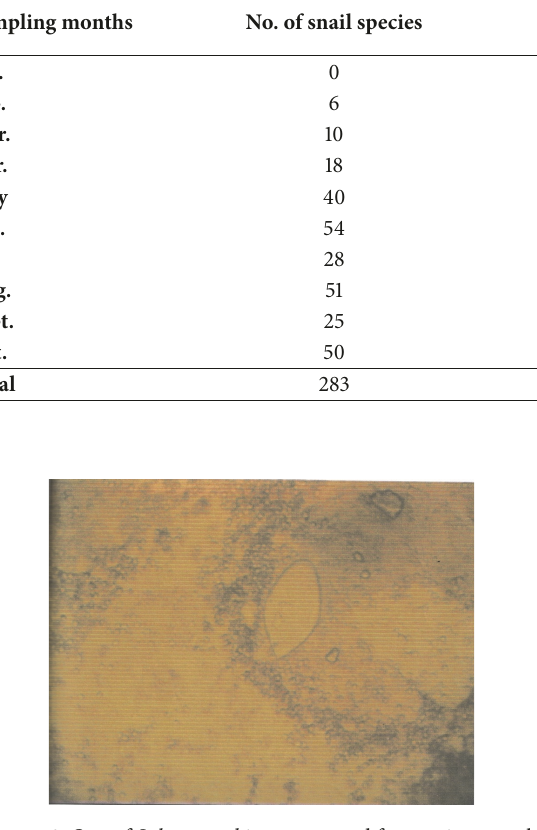
Figure 3: Ova of S. haematobium recovered from urine sample.